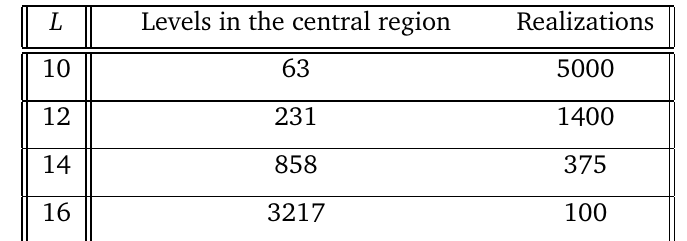
Table 1: Number of levels in the central region of the spectrum that is considered in the calculations N = d / 4 and number of realizations for each value of the number of sites L in the J - J model, Eq. (1). The corresponding eigenvalues { E 1 2 〉} eigenstates {| E have been obtained by exact n n